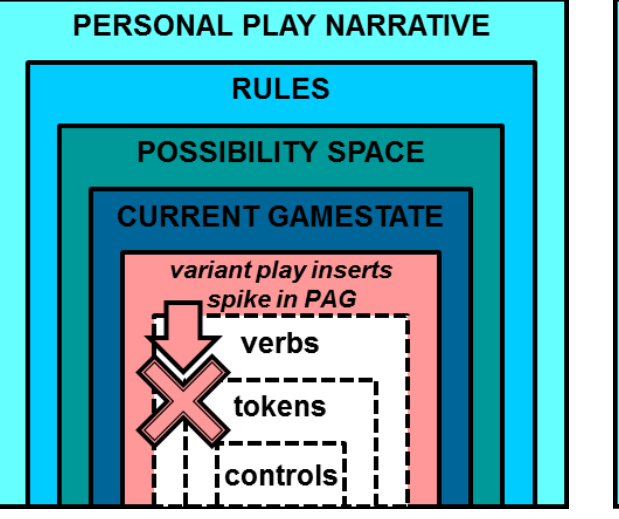
Figure 4 | PAG becomes disconnected from tokens and controls. Figure 5 | Update to PAG in variant play is